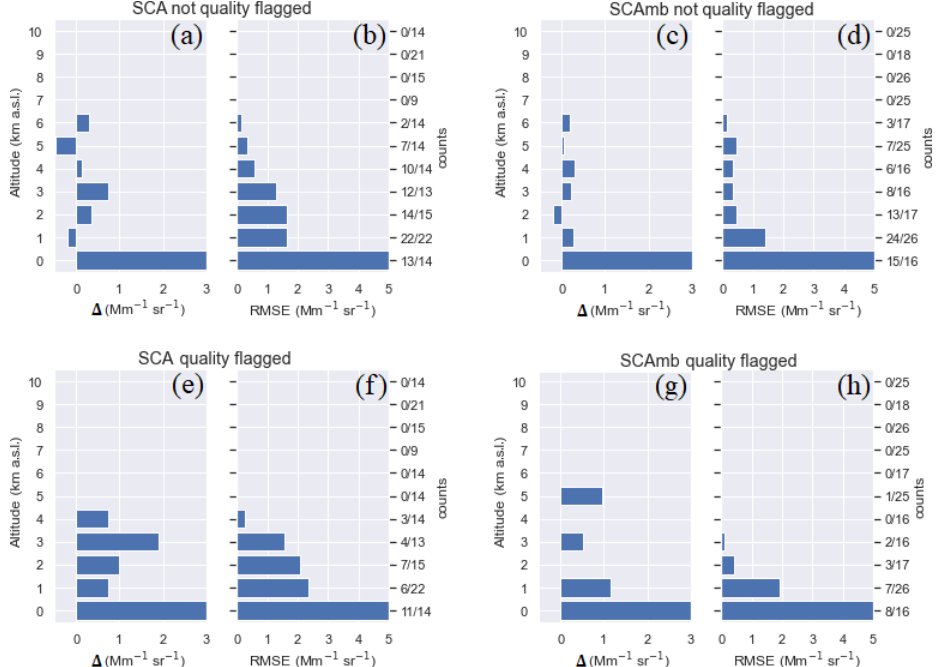
Figure 17. Statistical results for the intercomparison of Aeolus SCA and SCAmb products with Barcelona ground-based measurements, with and without quality flags. The right-hand axis indicates the number of available data points included in each vertical range out of the total number of measurements within that vertical range. The (a) difference ( (cid:49) ) and (b) RMSE of the intercomparison of the SCA products without quality flags applied. The (c) (cid:49) and (d) RMSE of the intercomparison of the SCAmb products without quality flags applied. Panels (e) and (f) are the same as panels (a) and (b) , respectively, but considering quality flags. Panels (g) and (h) are the same as panels (c) and (d) , respectively, but considering quality